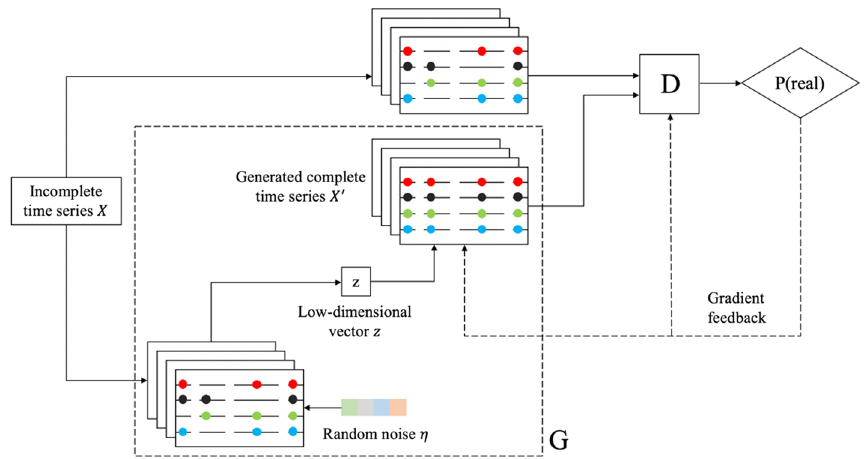
Fig. 1 The architecture of the proposed